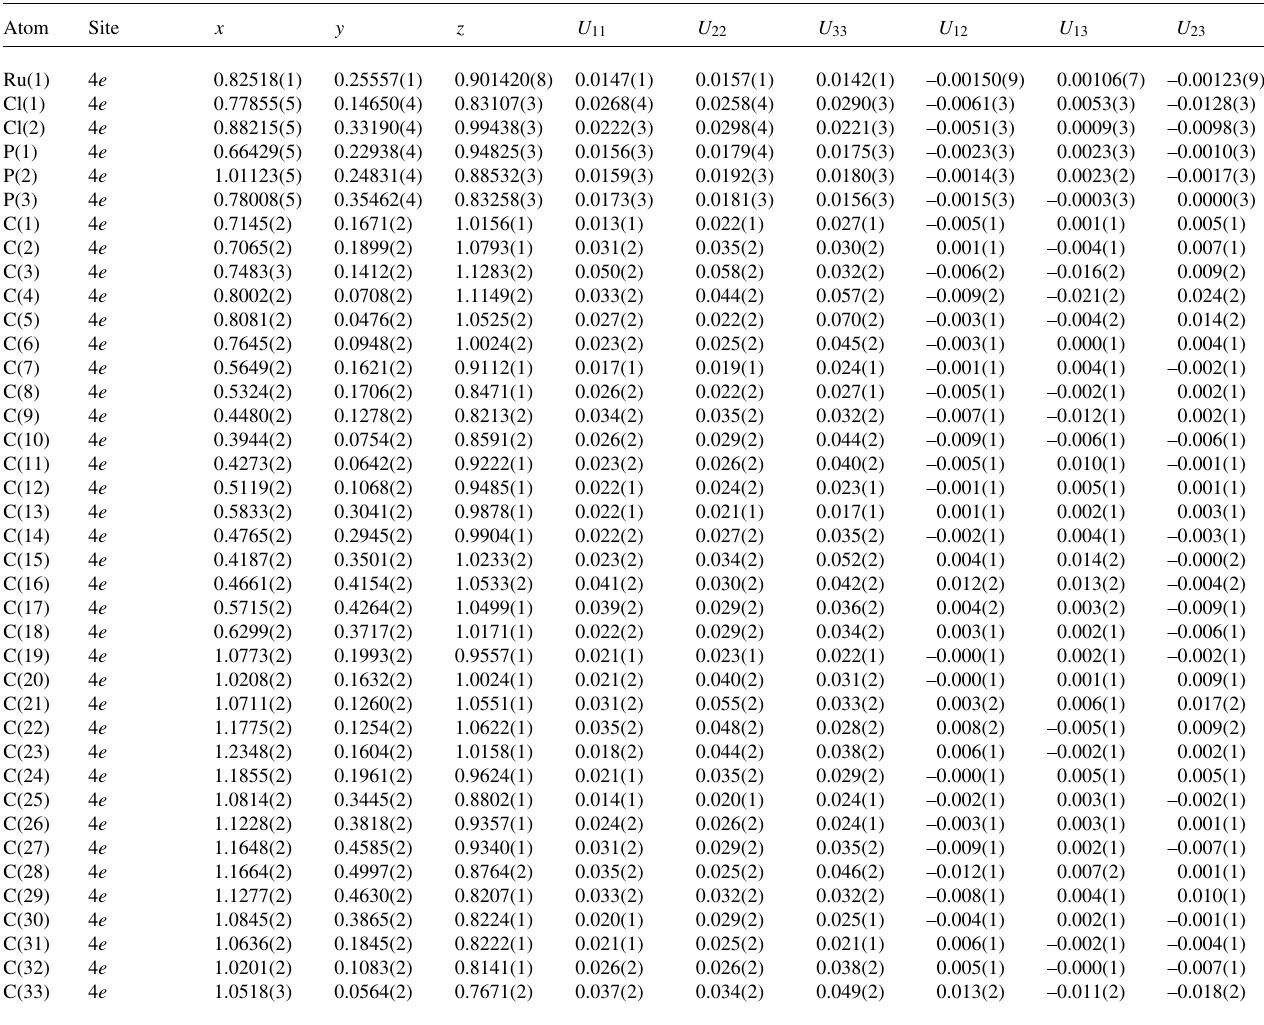
Table 3. Atomic coordinates and displacement parameters (in Å 2 ) .